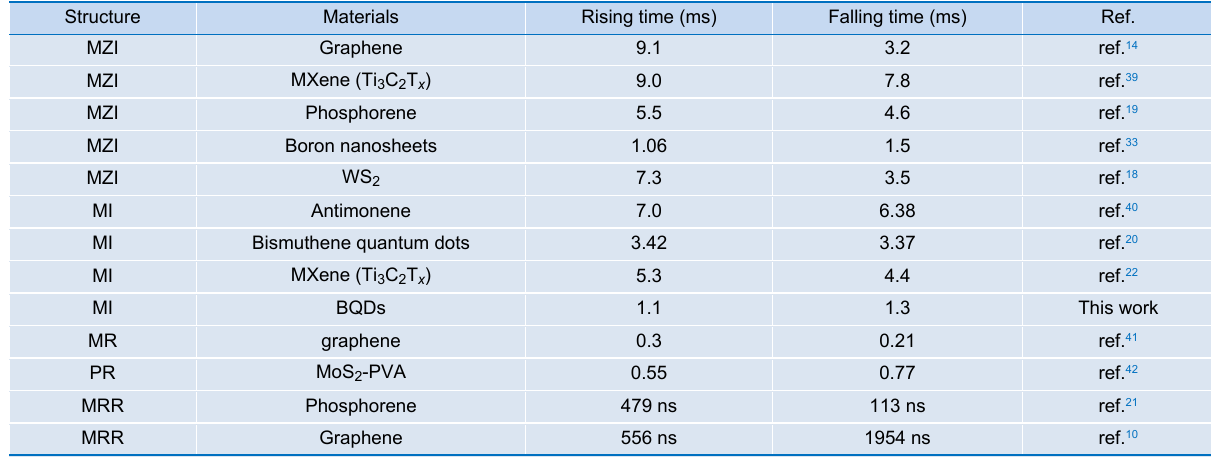
Table 1 | The current state-of-the-art all-optical modulator based on photothermal effect.